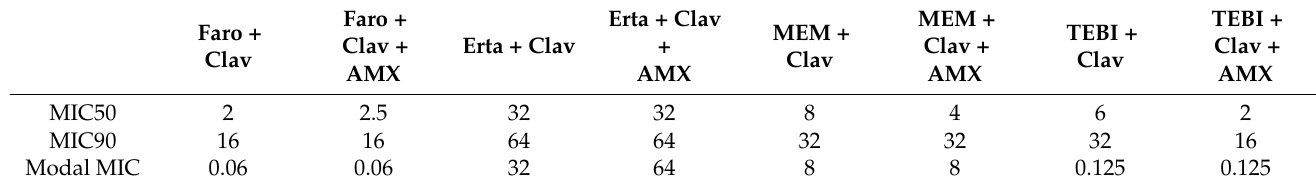
Table 4. MIC 50 , MIC 90 and modal MIC values of carbapenems in association with clavulanic acid alone as well as clavulanic acid and amoxicillin for strains with resistance to one or more first- and second-line drugs. Clavulanic acid was used at a fixed concentration of 2.5 mg/L, and amoxicillin was used at a fixed concentration of 2 mg/L. Faro, faropenem; Clav, clavulanic acid; AMX, amoxicillin; Erta, ertapenem; MEM, meropenem; TEBI,